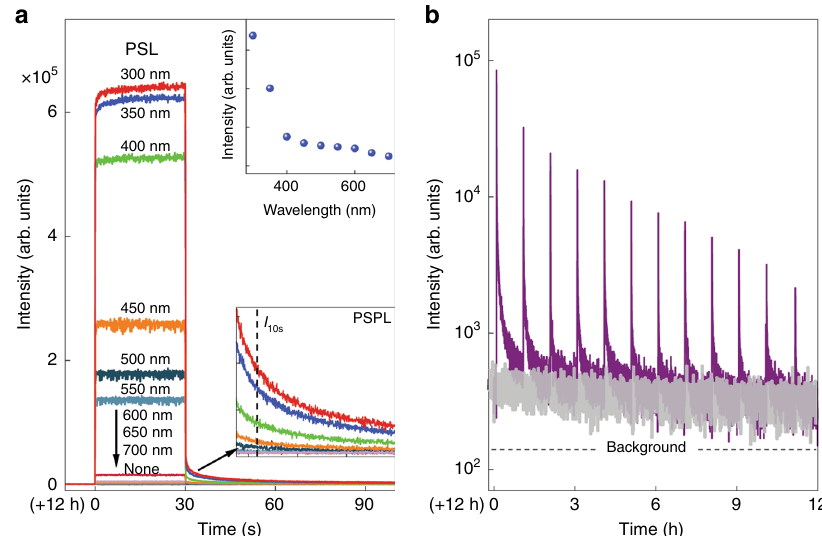
Fig. 4 Photostimulation effects on decayed Ca 2 Al 2 SiO 7 :Pr 3 + discs. a Photostimulated luminescence (PSL) spectra and photostimulated persistent luminescence (PSPL) decay curves of a 12 h decayed disc (in darkness; pre-irradiated by a 254 nm lamp for 2 min) under and after 300 – 700 nm monochromatic light stimulation for 30 s. The monitoring wavelength is 268 nm. The lower inset shows the enlarged PSPL decay curves. The PSPL intensity at time of 10 s ( I 10s ) after the stoppage of the stimulation was used to plot the PSPL intensity as a function of stimulation wavelengths, as shown in the upper inset. b Repeated PSPL decay curves obtained on a 12 h decayed disc (in darkness; pre-irradiated by a 254 nm lamp for 2 min). The monitoring wavelength is 268 nm. The decayed disc was irradiated by a 3800 Lumen white LED fl ashlight for 10 s at every 1 h for a total of 12 times to elicit the ultraviolet-C PSPL signals. For comparison, the gray curve shows the continuous decay for another 12 h in darkness (i.e., without the LED fl ashlight irradiation). Source data are provided as a Source Data fi